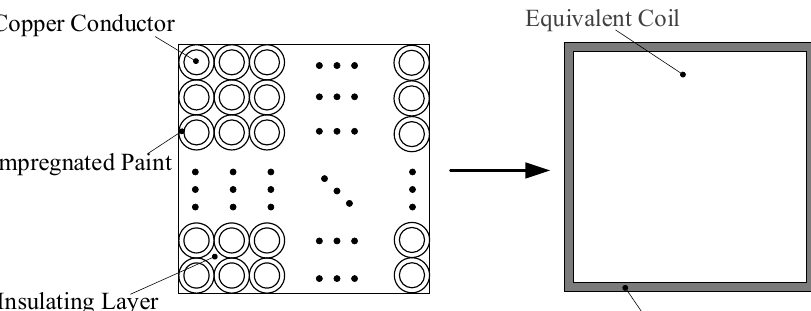
Figure 4. Coil winding structure and simplified model.